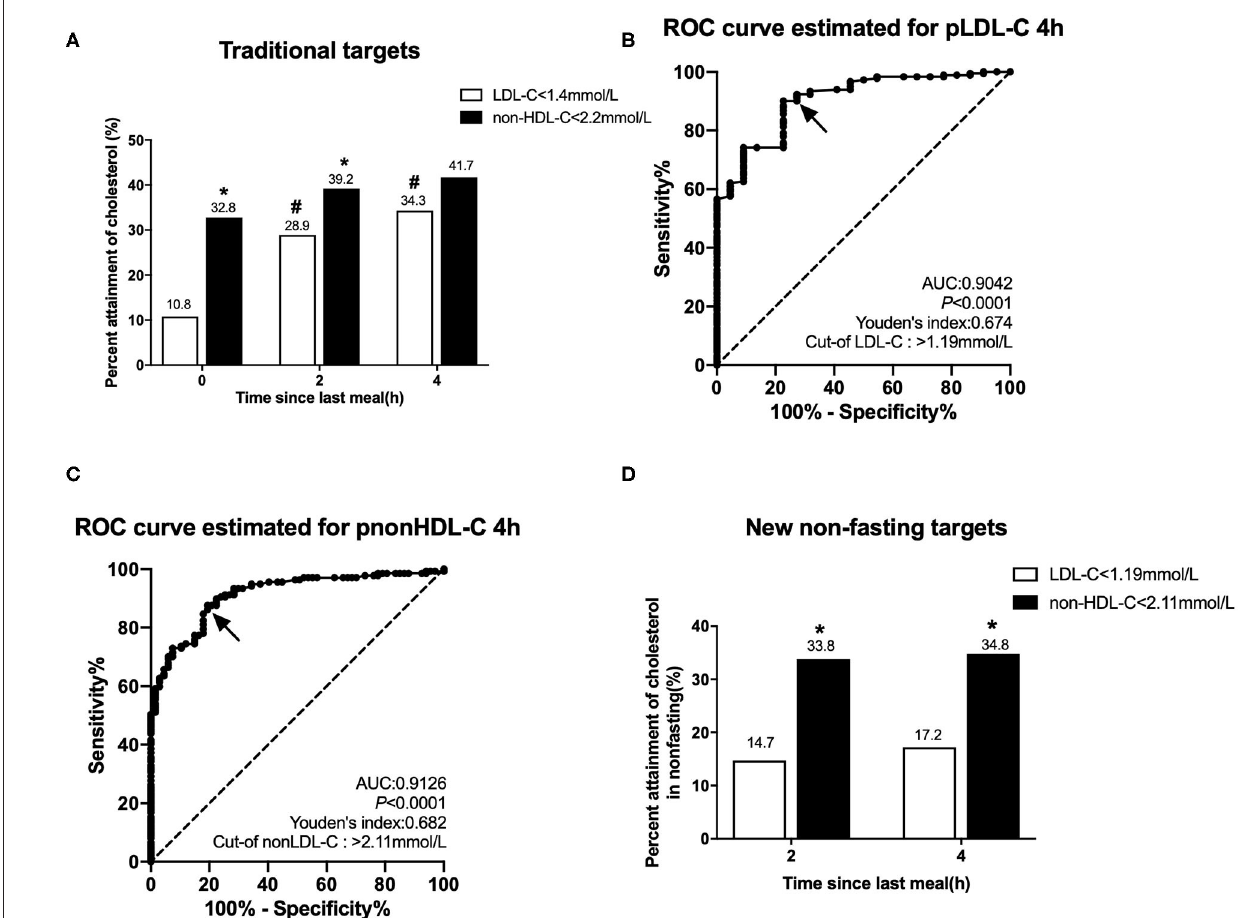
FIGURE 2 | Comparison of the percent attainments of LDL-C and non-HDL-C levels according to different targets in fasting and non-fasting states in Group CHD2. CHD2 group: CHD patients taking statins ≥ 1m before admission. (A) Comparison of the percent attainments in both fasting and non-fasting states according to the recommended targets of LDL-C level < 1.4 mmol/L and non-HDL-C level < 2.2 mmol/L. (B,C) Non-fasting cut-off points in relation to fasting LDL-C level 1.4 mmol/L (B) and non-HDL-C level 2.2 mmol/L (C) determined by ROC analysis and Youden’s index (marked by the solid arrows). (D) Comparison of the percent